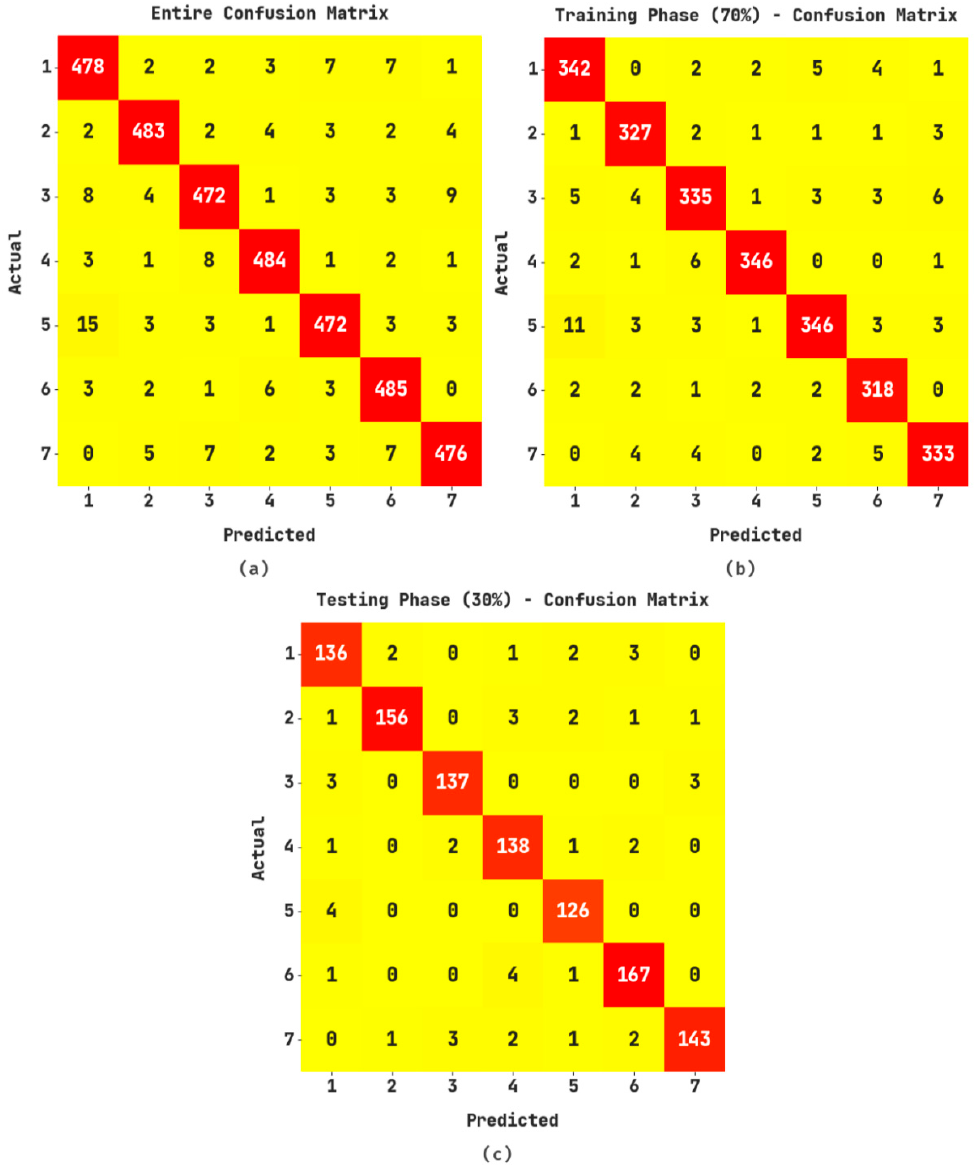
Figure 3. Confusion matrices of CLBEDC-SND approach ( a ) Entire dataset, ( b ) 70% of TR data, and ( c ) 30% of TS data.